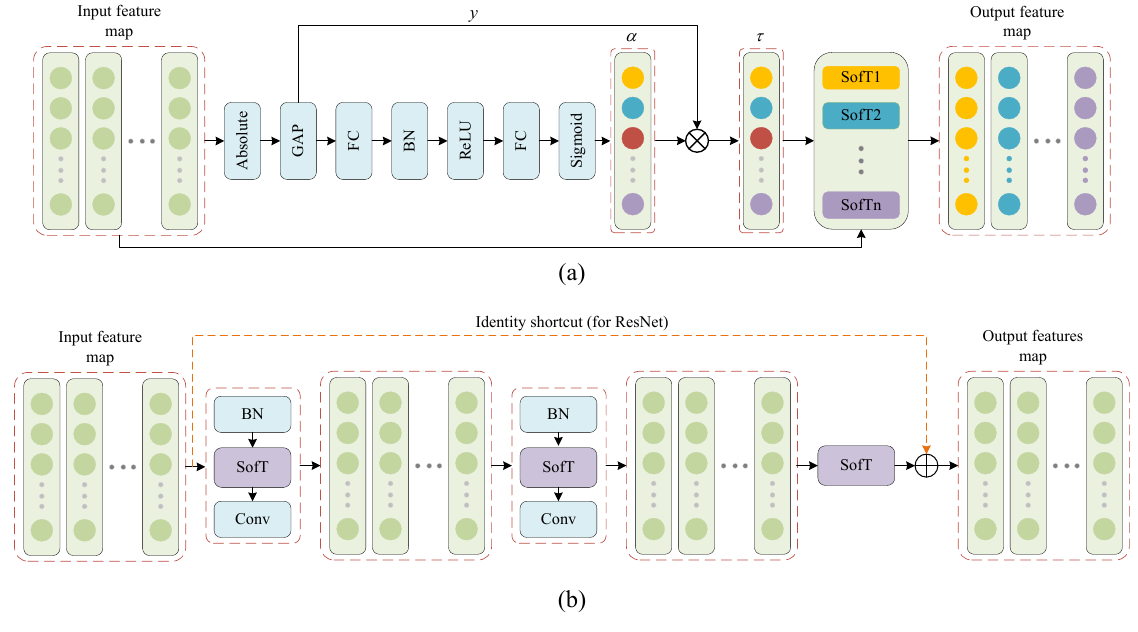
Figure 2. ( a ) Threshold module, ( b ) residual building unit